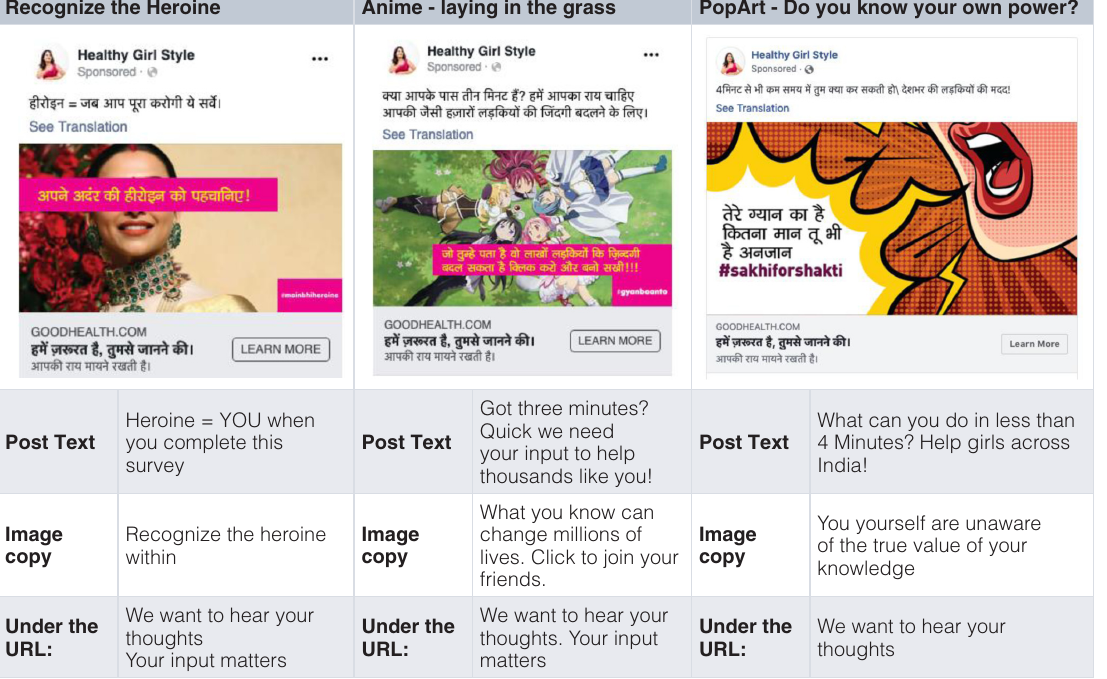
Table 2. Top performing campaign creative. Recognize the